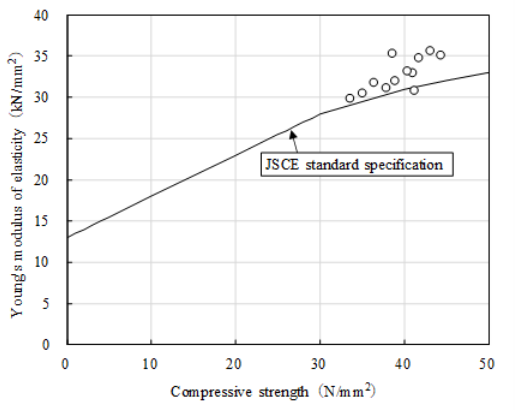
Figure 10. Compressive strength. Figure 11. Relationship between Young’s modulus and compressive strength.